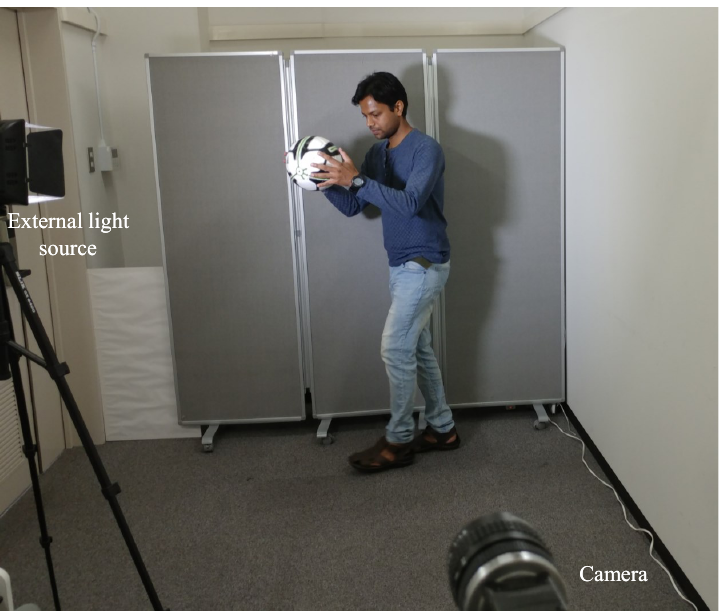
Figure 17. Experiment setup for HFR-projector–camera system using a USB camera as input.